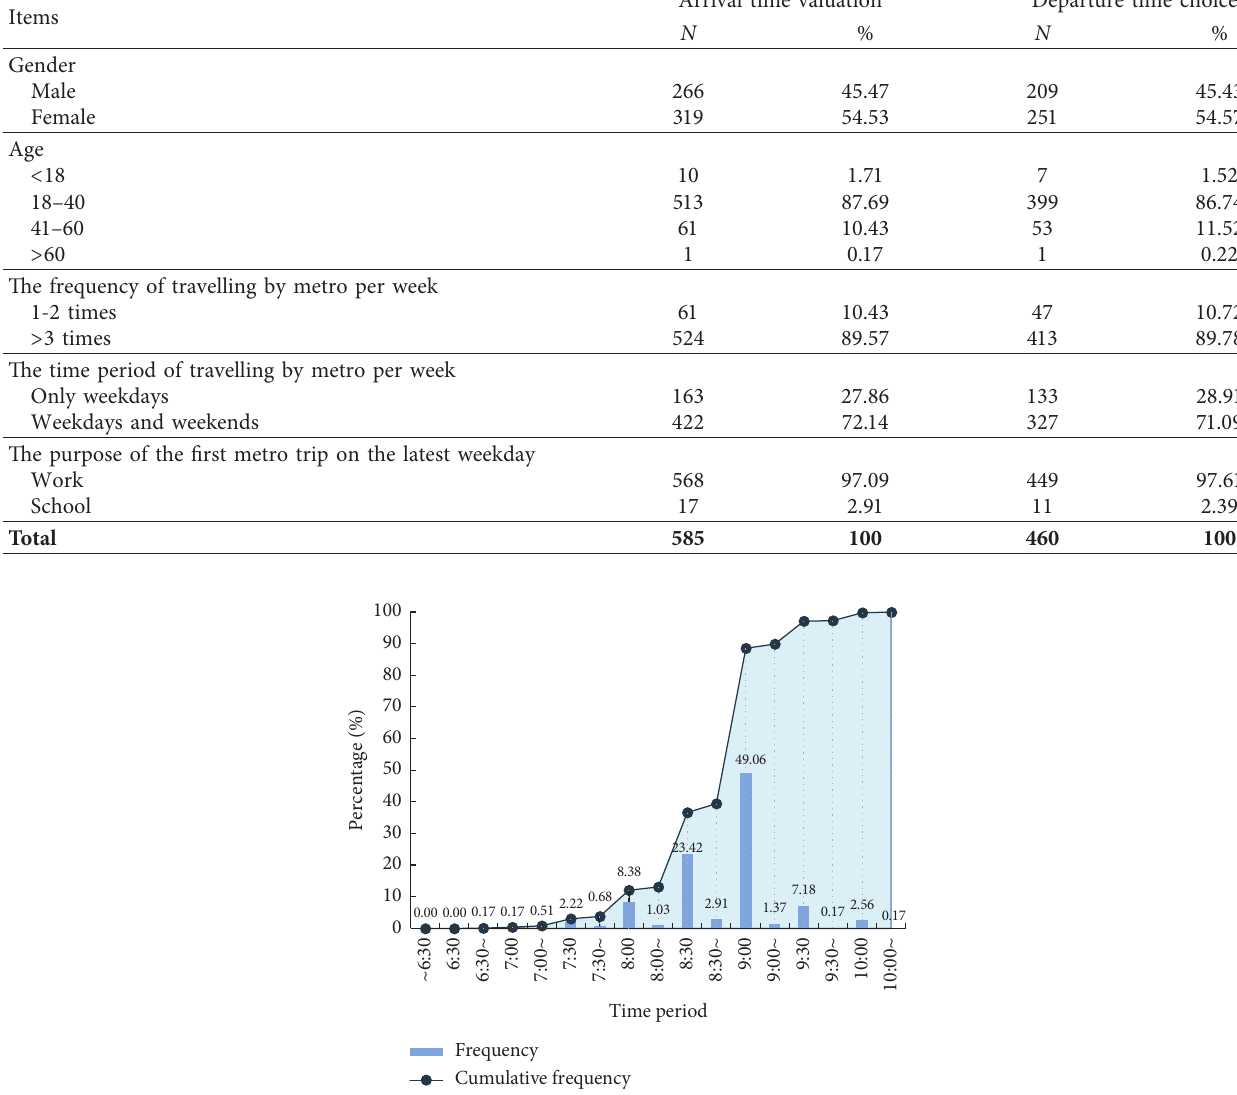
Figure 1: The distribution of work/school start time. Table 5: Time points related to arrival time